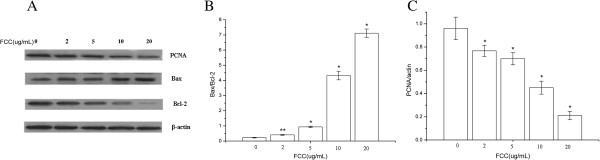
Effects of FCC treatment on PCNA, Bax, and Bcl-2 expression. (A) SMMC-7721 cells were treated with FCC at doses of 0, 2, 5, 10 and 20 μg/ml for 48 h. The cell lysates were prepared and analyzed for PCNA, Bax and Bcl-2 expression by Western blot analysis. Equal loading was confirmed by stripping immunoblots and reprobing for β-actin. Data shown were representatives of three experiments. (B) Statistical analysis of PCNA quantification. (C) The ratio of Bax to Bcl-2 protein. *p < 0.05, **p < 0.01, compared with control.